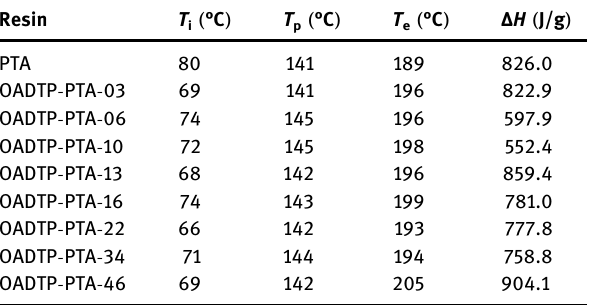
Table 2: DSC analysis results of OADTP - resins